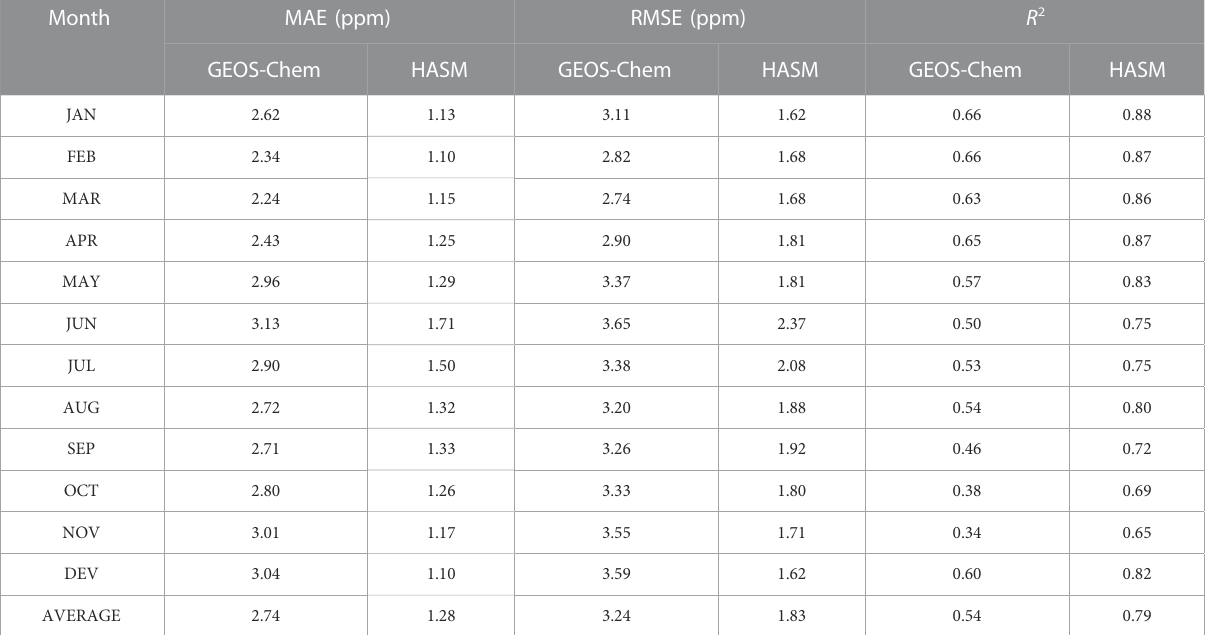
TABLE 1 Monthly error statistics in